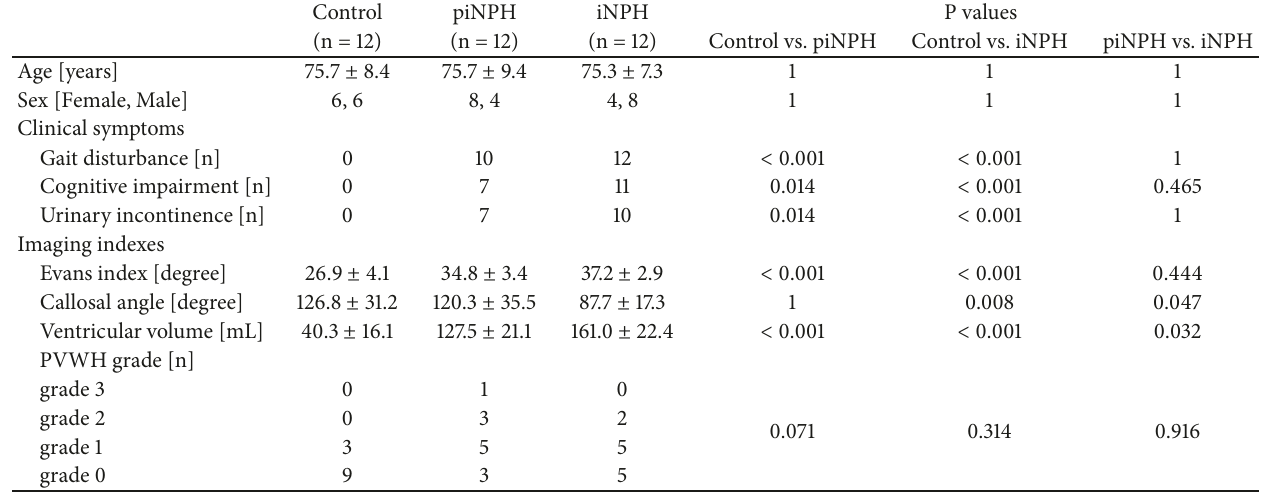
Table 2: Patient characteristics.